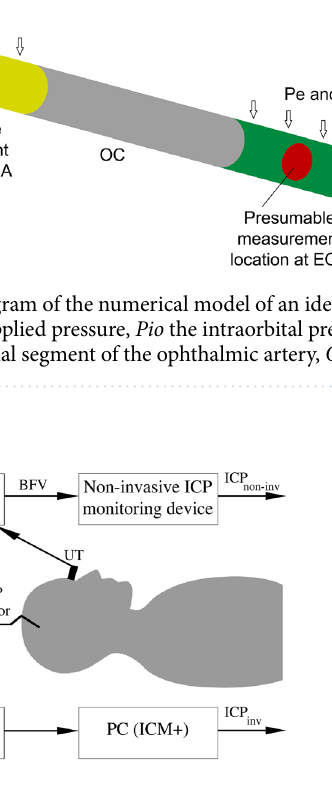
Figure 2. The set-up for simultaneous invasive and non-invasive intracranial pressure monitoring. UT ultrasonic transducer, BFV blood flow velocity, TCD transcranial Doppler, ICP inv invasively monitored intracranial pressure, ICP non-inv non-invasively monitored intracranial